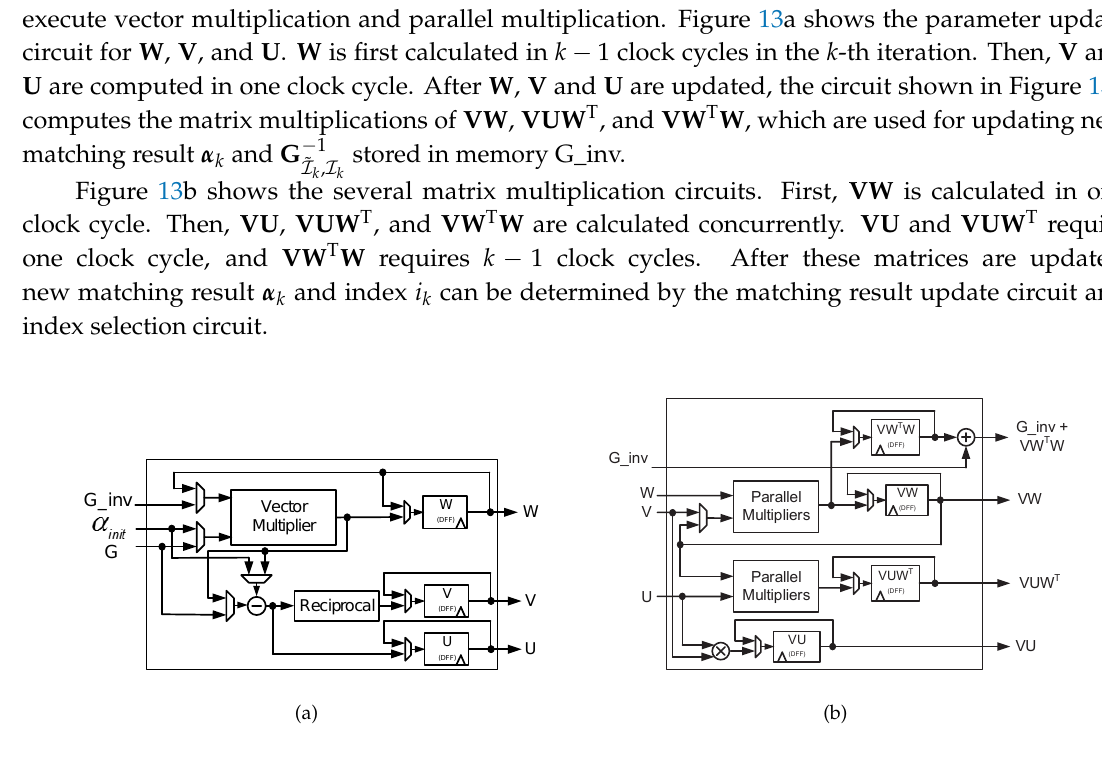
Figure 13. Architecture of parameter update unit where ( a ) updates W , V , U and ( b ) updates G_inv, VUW T , VU